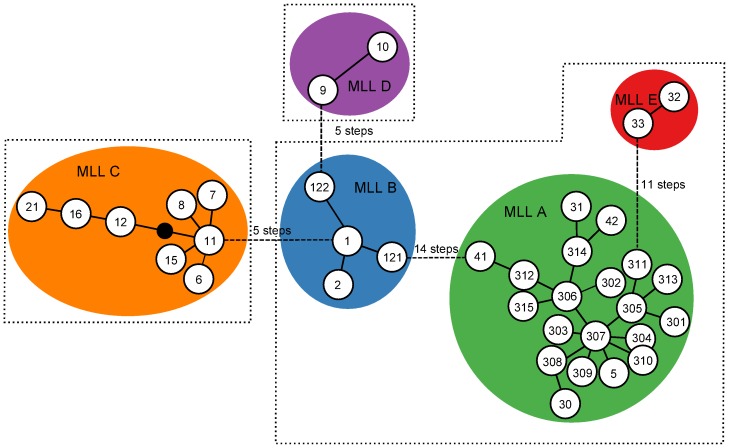
Minimum spanning network of Melanaphis sacchari microsatellite distances computed as the number of allele differences between MLGs. Each node represents one step in the network, i.e. a distance of one allele.The numbers in the circles represent MLGs according to Table 1. Coloured backgrounds represent the Multi Locus Lineages (MLLs). MLGs in the same dashed line box share the same COI haplotype.